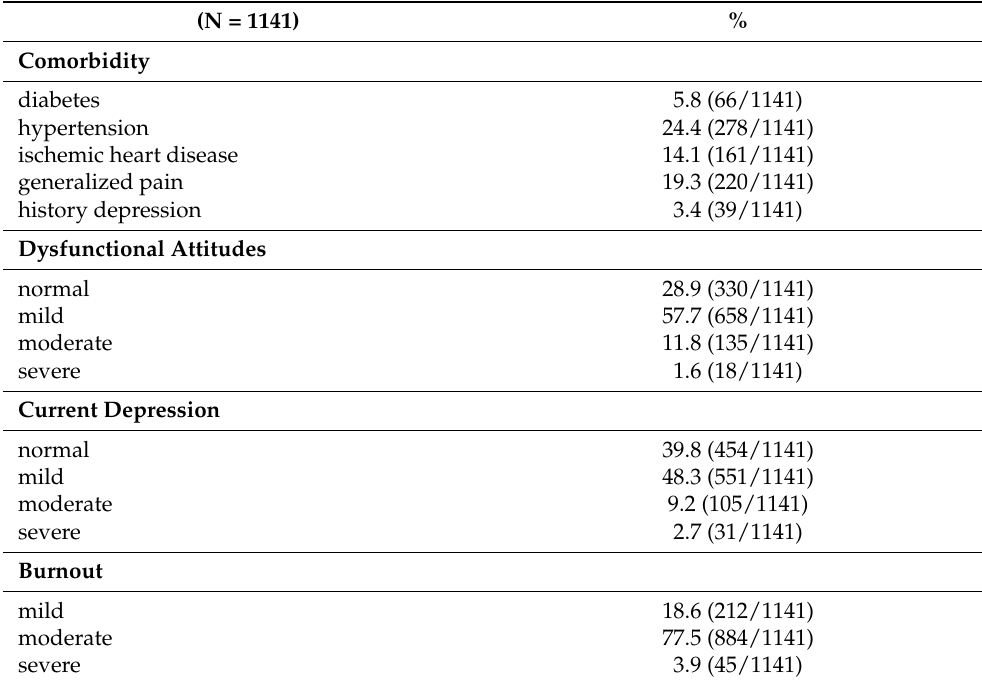
Table 2. Comorbidity, dysfunctional attitudes, depression and burnout in the study population.